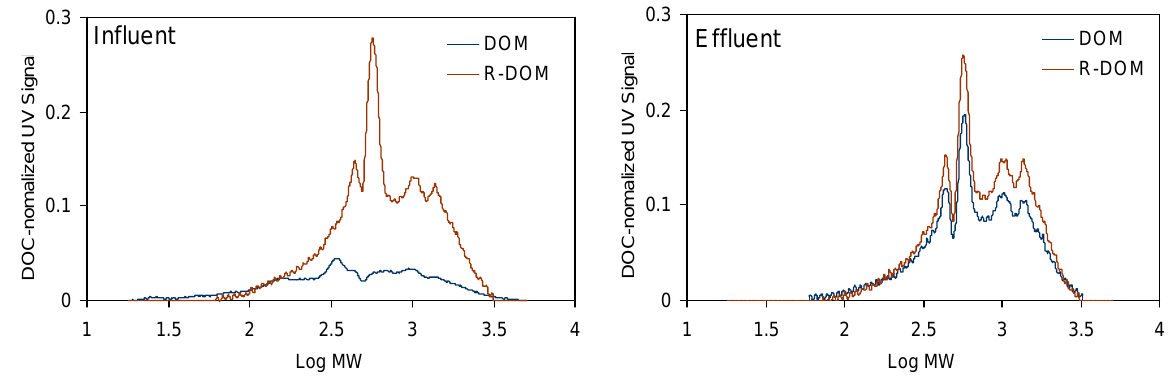
Figure 3. Size exclusion chromatograms of influent and effluent sewage from a wastewater treatment plant (DOM: dissolved organic matters, R-DOM: refractory dissolved organic matters).